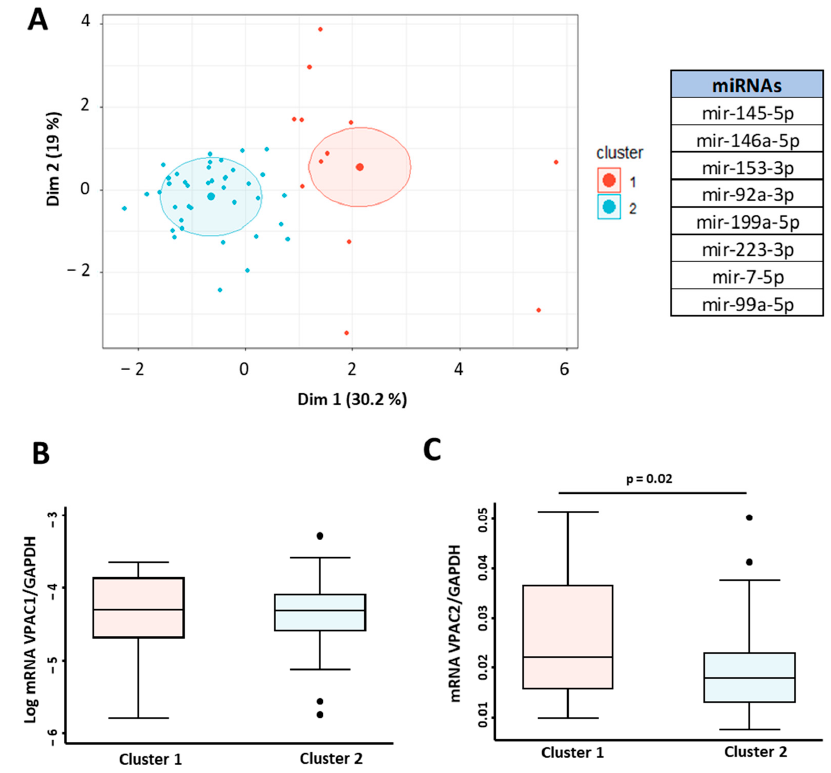
Figure 5. miRNA signature associated with VPAC receptors gene expression. ( A ) Cluster analysis in 52 IMID patients based on the expression of miRNAs miR145-5p, miR146A-5p, miR153-3p, miRNA92a-3p, miR199a-5p, miR223-3p, miR7-5p, and miR99a-5p. K-means clustering based on Euclidean distance and PCA was used for graphical representation. Log of relative expression (2 − ∆ Ct ) of VPAC1 / GAPDH ( B ) and VPAC2 / GAPDH mRNA ( C ) according to their association with miRNA expression cluster. Statistical significance was calculated using Student’s t -test. For both datasets, data are presented as the interquartile range (p75: upper edge of the box, p25: bottom edge of the box, and p50: midline) and p90 and p10 (lines below and above the box) of the relative gene expression. Dots represent outliers. Significance threshold was set at p <